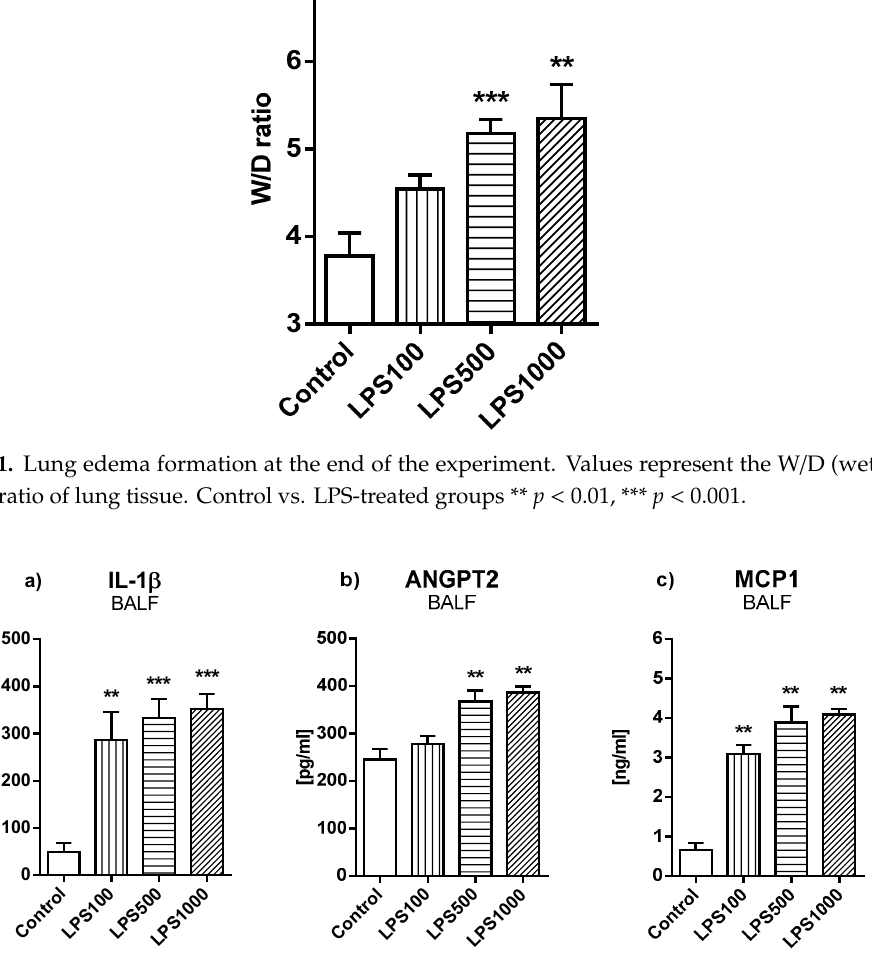
Figure 2. Levels of ( a ) Interleukin 1 β (IL-1 β ), ( b ) angiopoietin 2 (ANGPT2), and ( c ) monocyte chemotactic protein 1 (MCP1) in bronchoalveolar lavage fluid (BALF). Control vs. LPS-treated groups ** p < 0.01, *** p < 0.001.